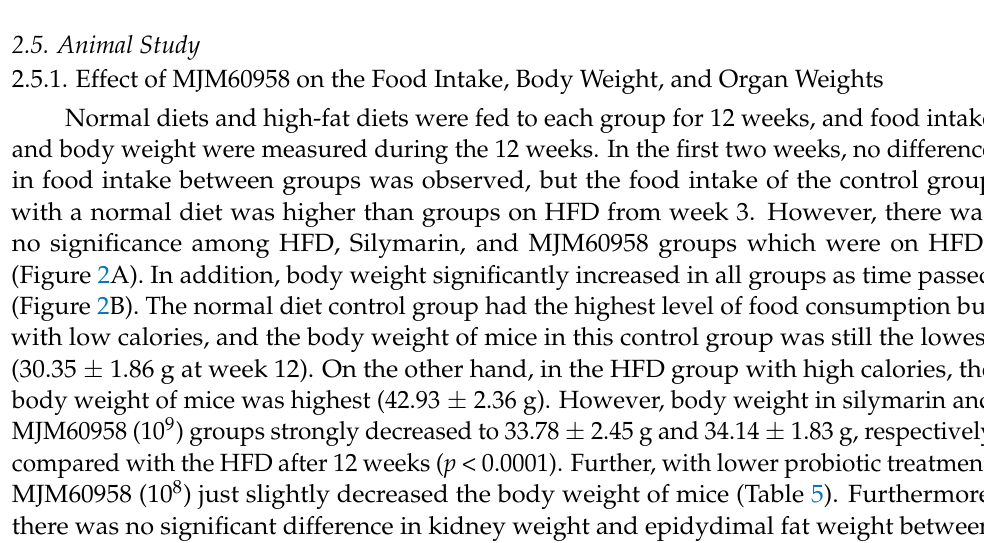
Table 4. Antibacterial activity of L. sakei MJM60958 and LGG against intestinal pathogens. Diameter of Zone Inhibition (mm) Strains L. sakei MJM60958